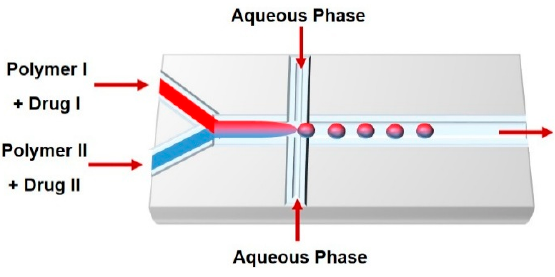
Figure 8. Schematic drawing of generation of Janus particles based on microfluidic chip.